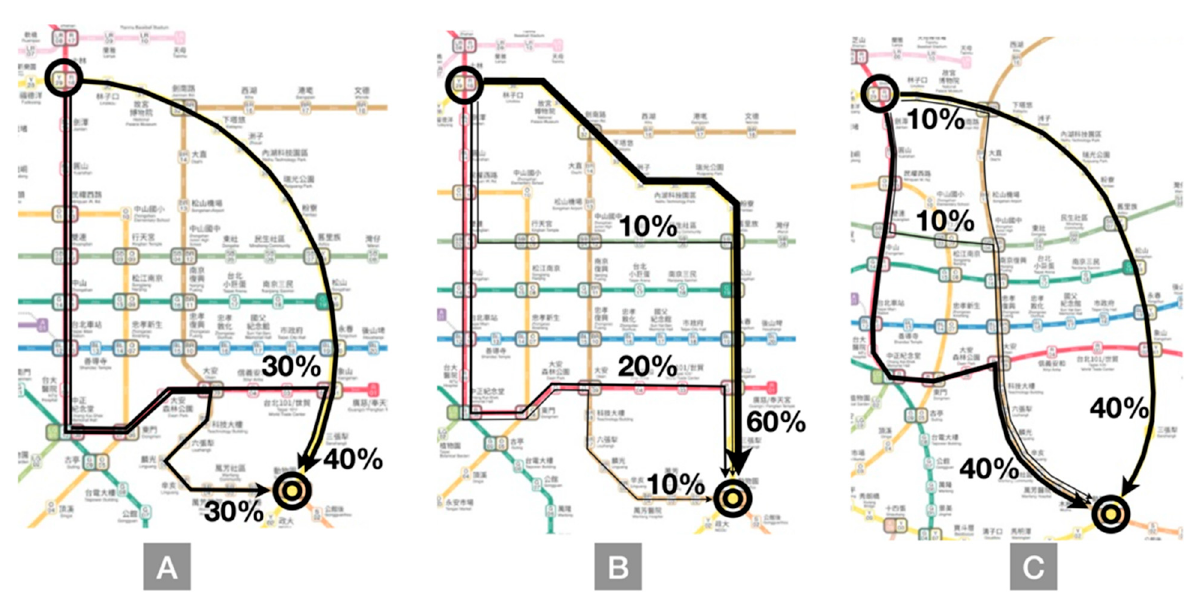
Figure 11. Proposal ( A – C ) showed participants’ route planning was affected by different representations of the same start-end stations.